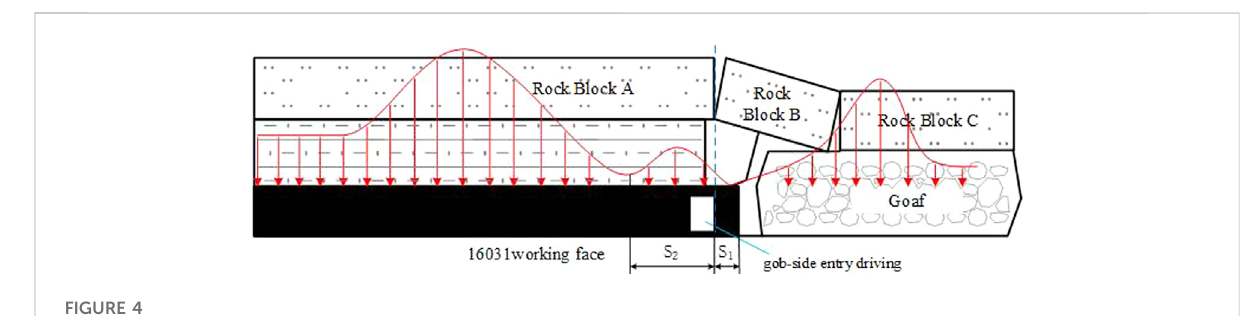
FIGURE 4 Distribution of the fi elds related to internal and external